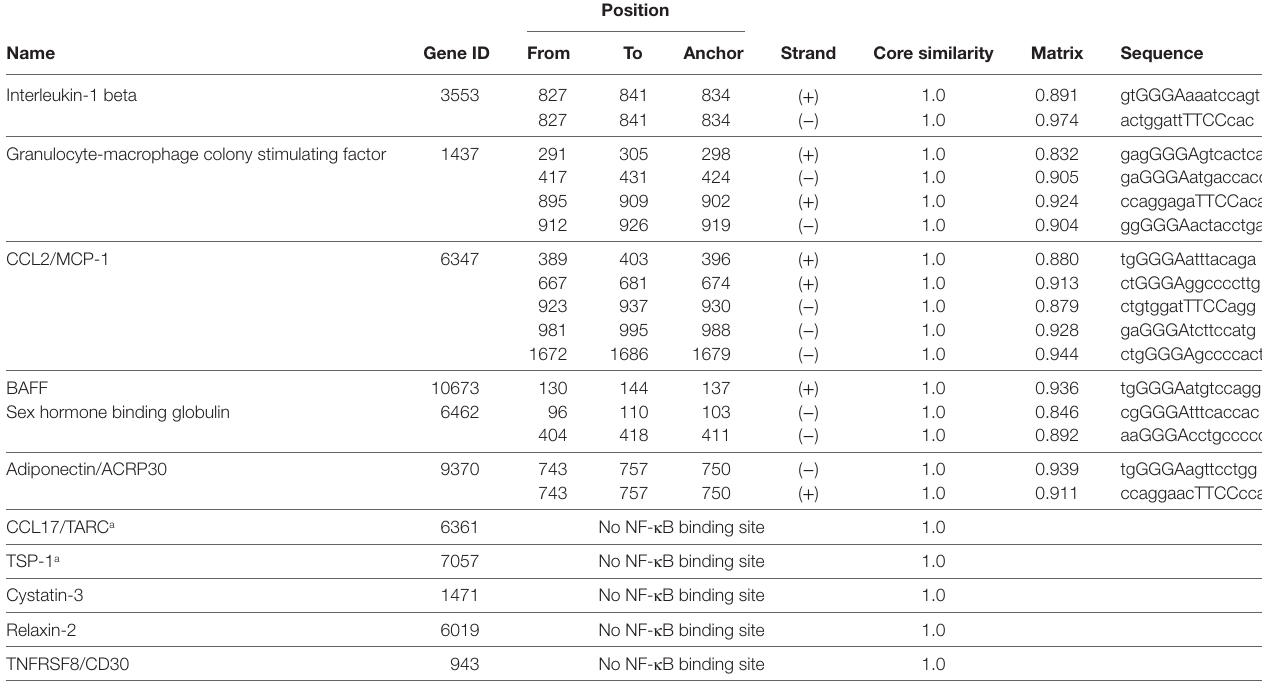
TaBle 1 | Analysis of nuclear factor-kappa B (NF- κ B) transcriptional binding sites on the differentially expressed cytokine genes following adenosine triphosphate stimulated and treatment with withaferin A of THP-1 cells.